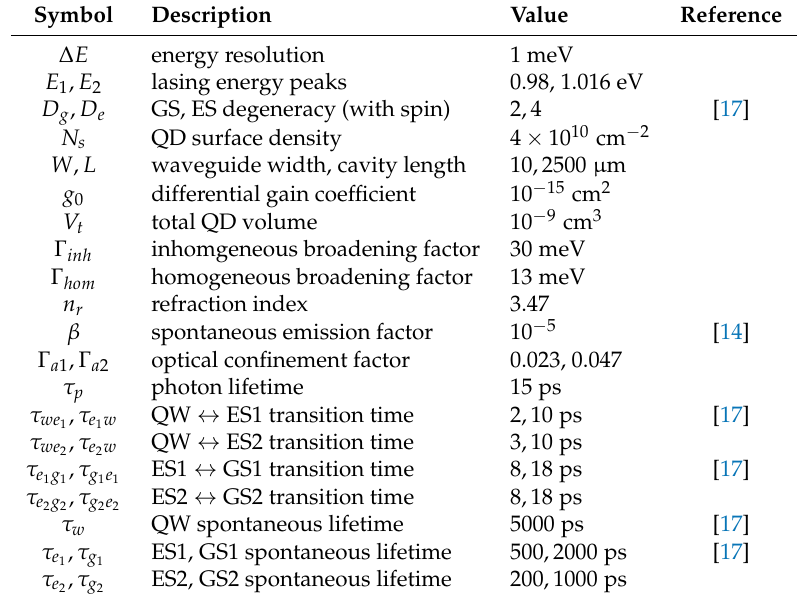
Table 1. Device parameters for digitally chirped multilayer quantum-dot (DC-MQD) lasers.